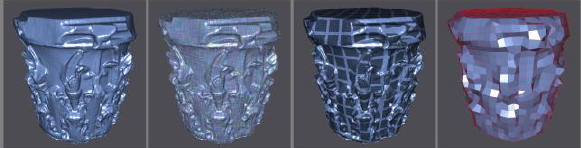
Figure 4. Bitmap segmentation starting from an optimized (u,v) Figure 2. Steps for automatic retopology of a capital high-poly layout: manual or semi-automatic editing of the bitmap leads to mesh into a pure-quad mesh by means of Instant Meshes the possibility to improve on a single surface different BRDF application.